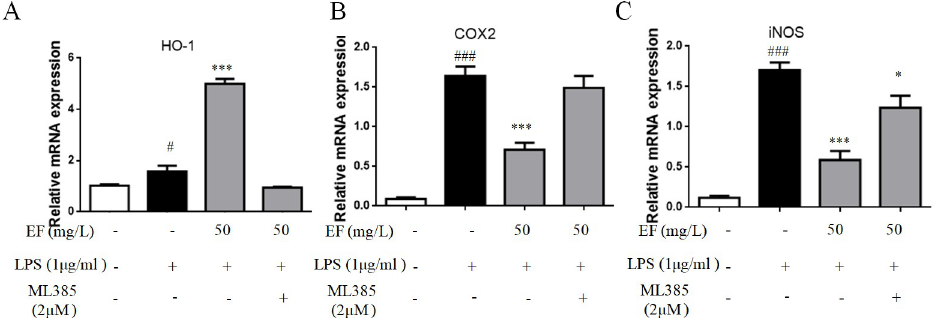
Fig 8. The inhibition of Nrf-2 reduced the mRNA of HO-1 and increased the mRNA of COX2 and iNOS. A/B/C: The mRNA levels of HO-1, iNOS and COX-2 were determined by quantitative real-time PCR. All data are shown as mean ± SEM (n = 6, per group) #P < 0.05, ###P < 0.001 vs control; � P < 0.05, ��� P < 0.001 vs LPS.